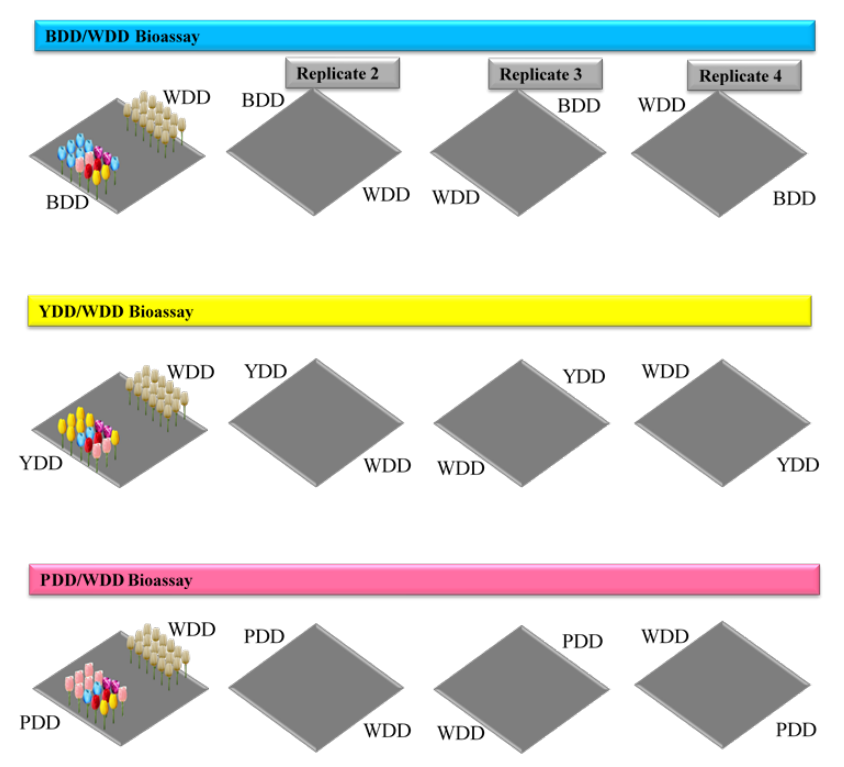
Figure 2. Bioassay layout. The two flower arrangements to be tested were placed at two opposite sides of the enclosure. To prevent position bias, we ran a dual-choice test design following a clockwise replication system, in which a test replicate corresponded to the disposition of two floral designs (one test design and one control design). The same replication strategy was also applied to control enclosures (two WDDs).